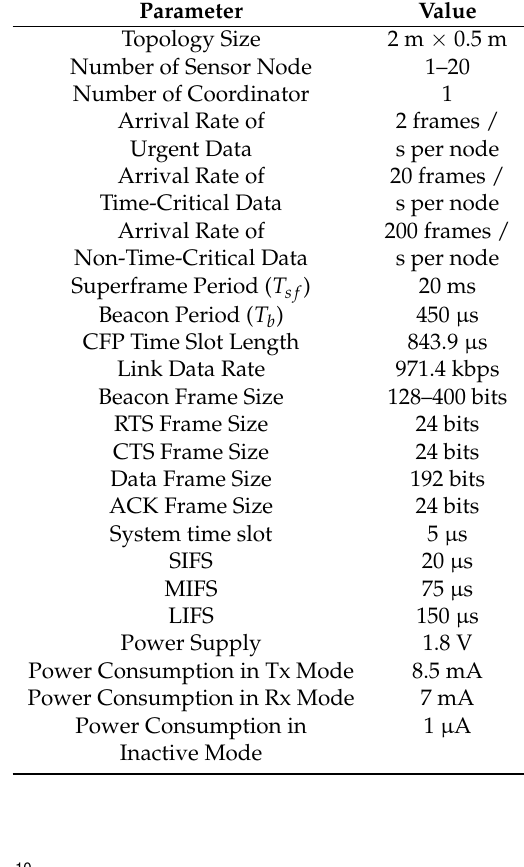
Table 2. Simulation parameters.